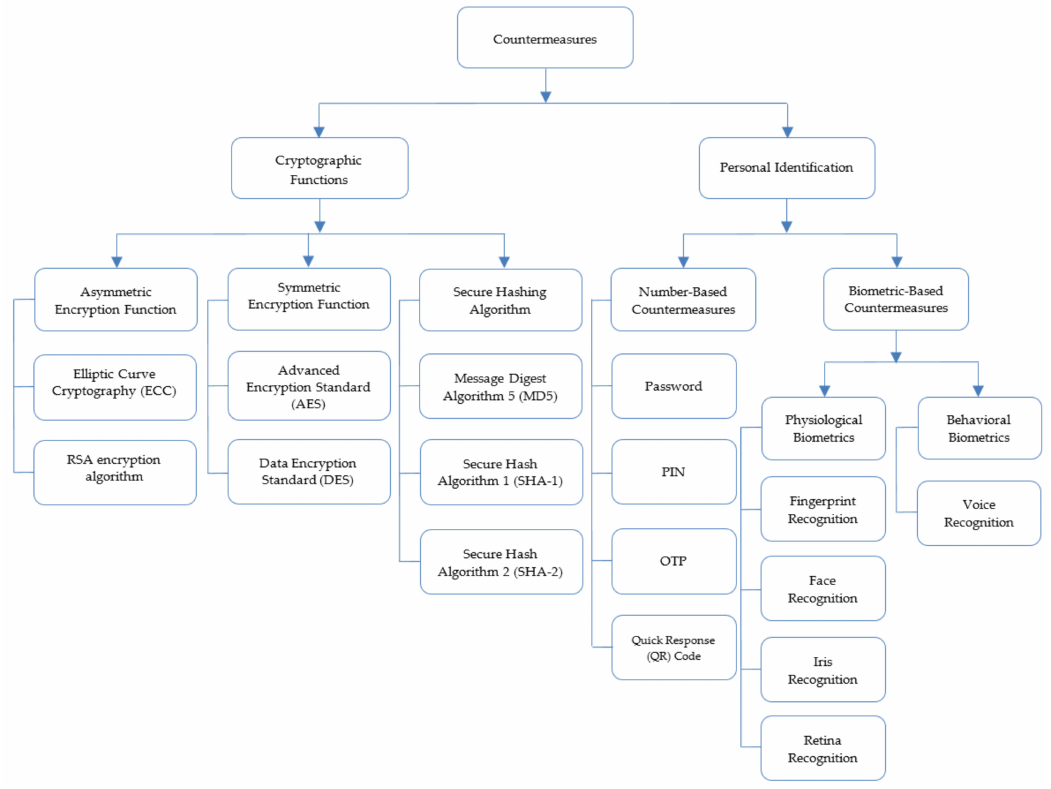
Figure 6. Countermeasures against attacks in mobile money’s 2FA